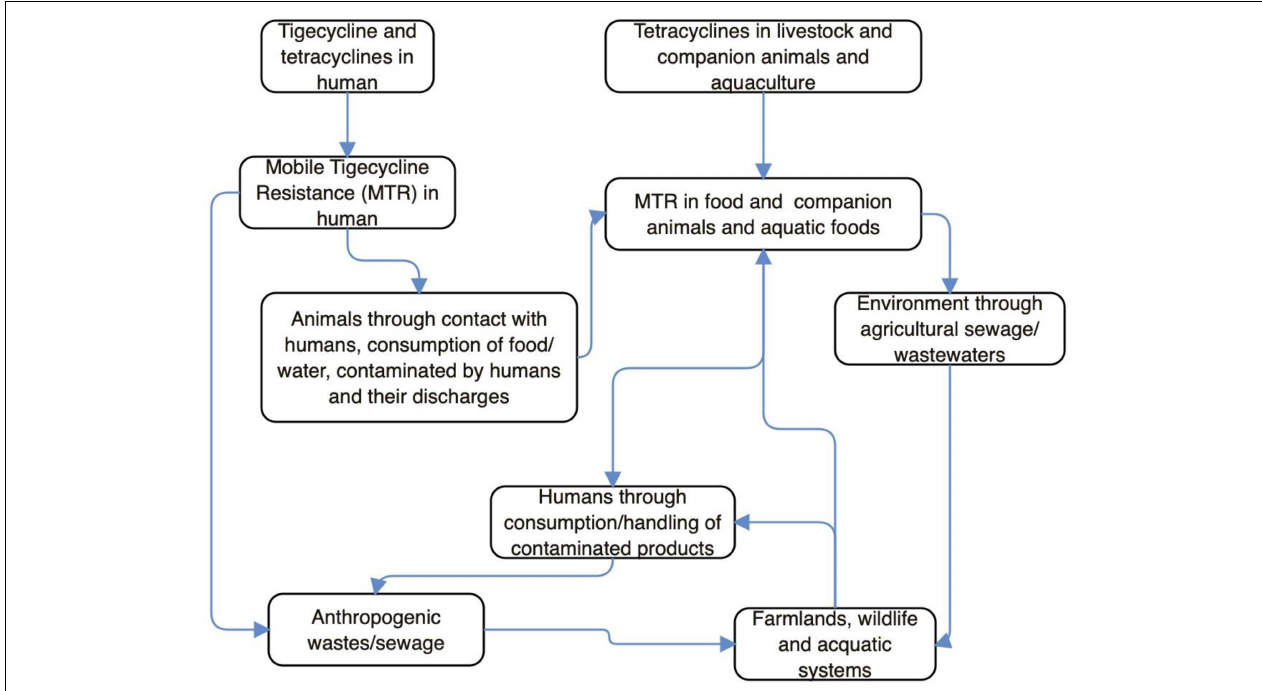
FIGURE 1 | Potential pathways through which mobile tigecycline resistance (MTR) emerges and builds up in human, animal, and environmental ecosystems.